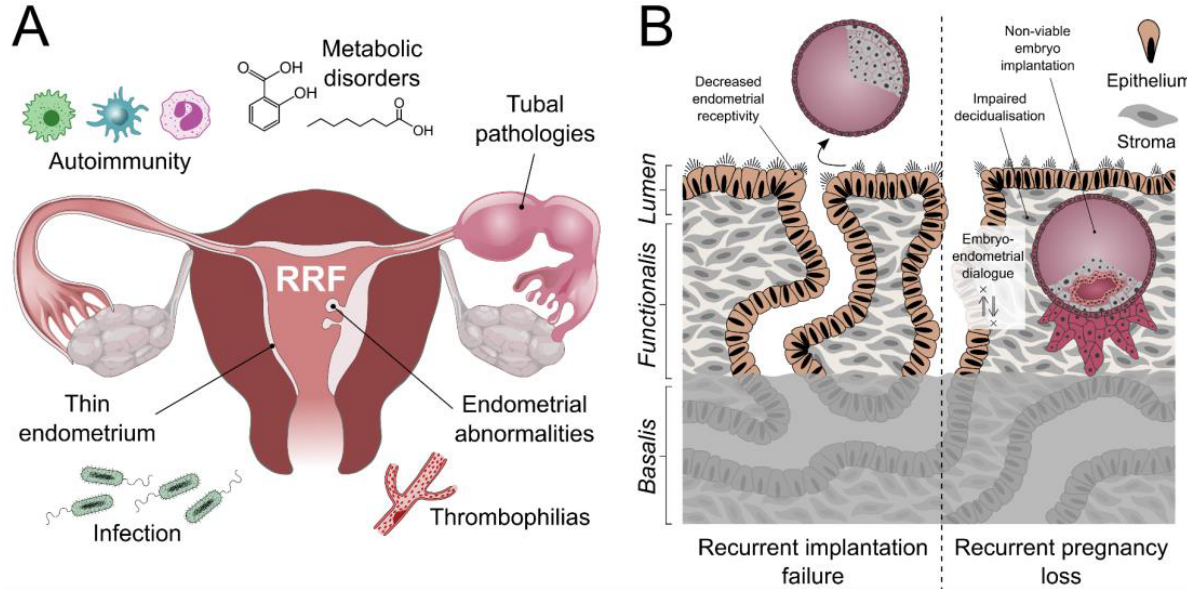
Figure 1. Aetiology of recurrent reproductive failure. ( A ) Risk factors for recurrent reproductive failure (RRF). ( B ) Demonstrable causes of recurrent implantation failure and recurrent pregnancy loss. The contribution of basalis-resident stem/progenitor cells and glandular architecture to RRF pathophysiology has yet to be fully explored.